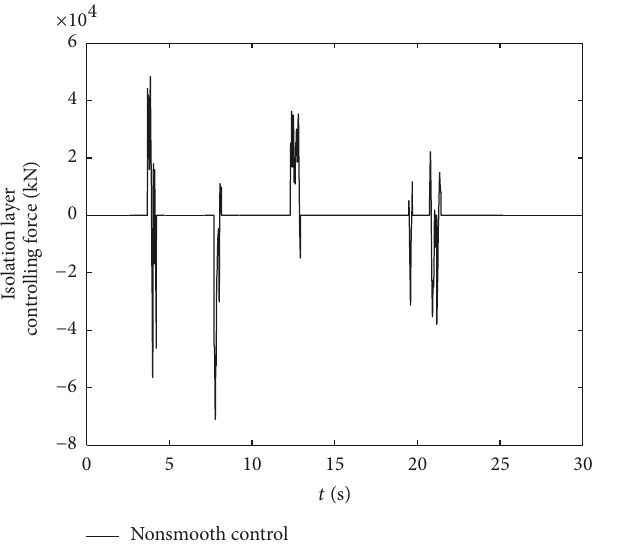
Figure 6: Control force response of isolation layer.